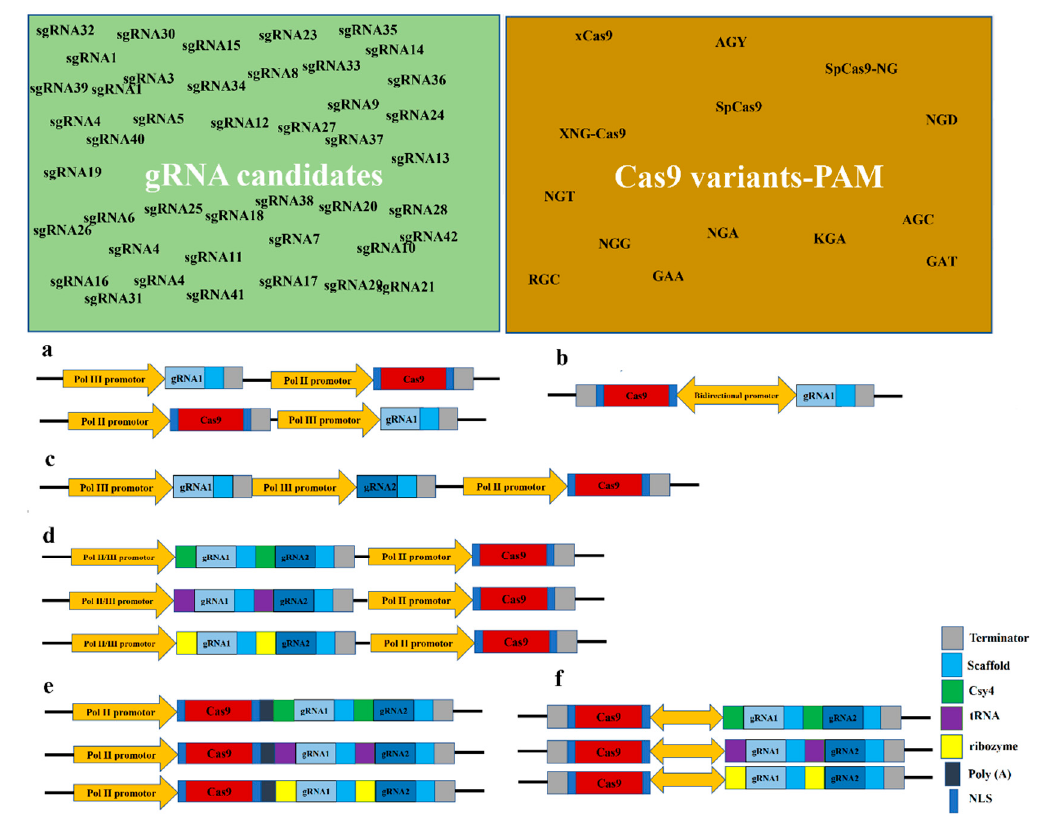
Figure 2. The multi-factorial nature of CRISPR/Cas9-based genome editing procedure considering configuration of gRNA and Cas9 expression cassettes along with different RNA processing strategies in multiplex gRNA experiments. ( a ) Simple TCTU configuration of gRNA and Cas9 cassettes in left and right borders of T-DNA. ( b ) Expression of gRNA and Cas9 cassettes in bidirectional promoter system. ( c ) Simple multiplex gRNA in TCTU system. ( d ) Multiplex gRNA in TCTU system with Csy4, tRNA, and ribozyme processing machines. ( e ) Multiplex gRNA in STU configuration with Csy4, tRNA, and ribozyme processing machines. ( f ) Bidirectional configuration of Cas9 and multiplex gRNA with Csy4, tRNA, and ribozyme processing machines.